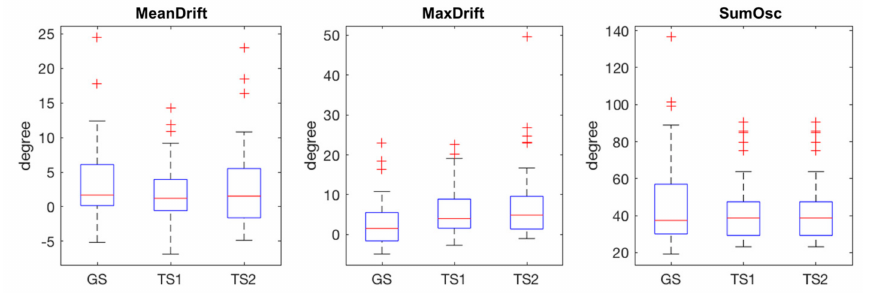
Figure 5. Statistical plots of measured features in GS, TS1, and TS2, red crosses are outliers.